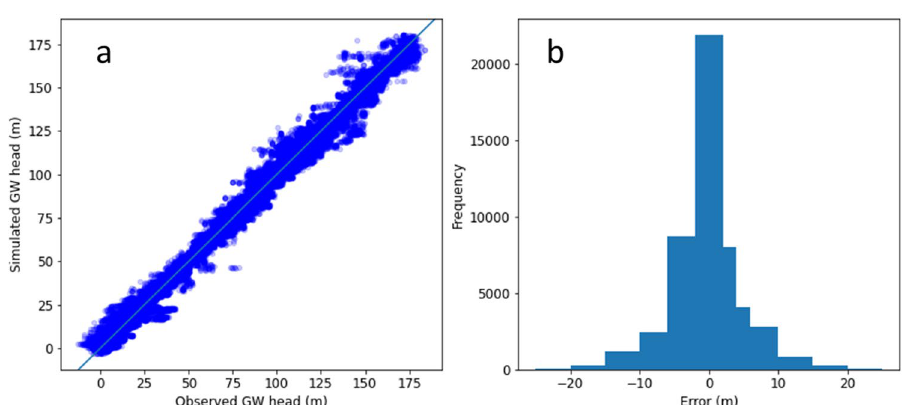
Figure 5. Match between simulated and observed groundwater head ( a ) and distribution of model calibration errors ( b